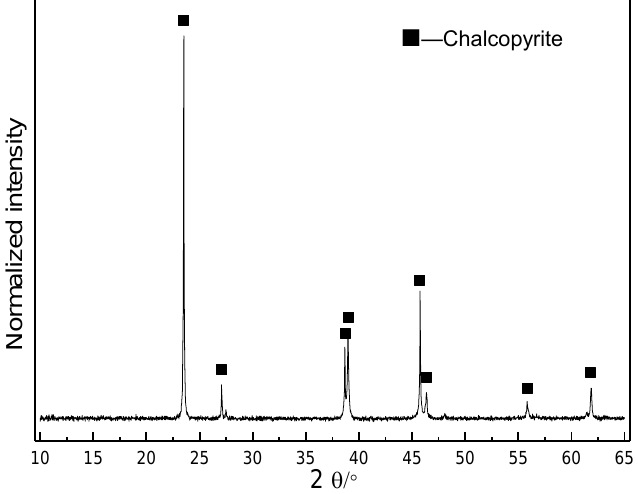
Figure 1. Synchrotron radiation-based X-ray diffraction (SR–XRD) patterns of original chalcopyrite.